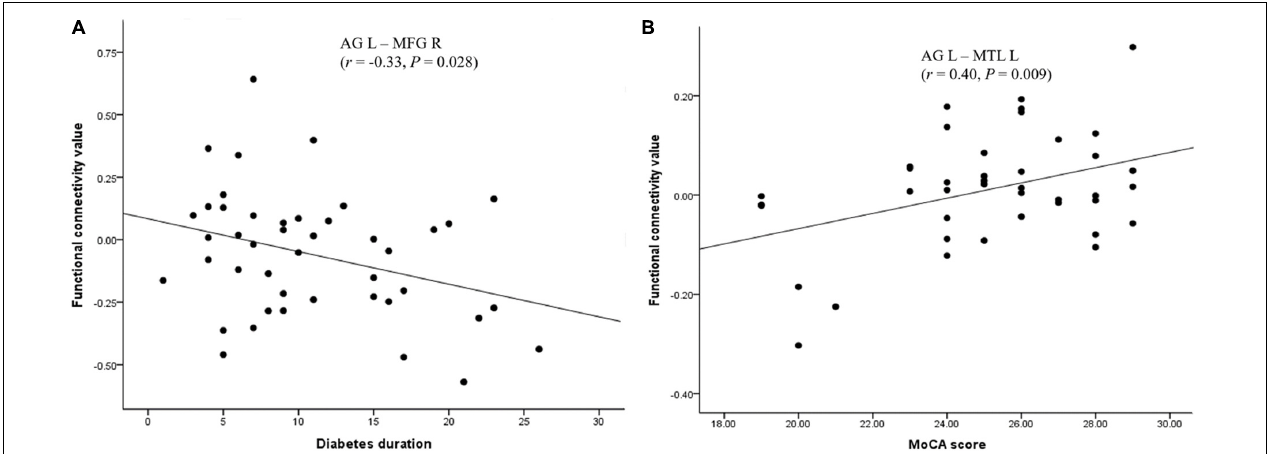
FIGURE 2 | Significant correlation between the FC of the AG and neuropsychological performances in the T2DM group. (A) Significant positive correlation of MoCA scores with the FC between the left AG and the left MTL. (B) Significant negative correlation of diabetes duration with the FC between the left AG and the right MFG. AG: angular gyrus; MTL: medial temporal lobe; MFG: middle frontal gyrus; MoCA: Montreal Cognitive